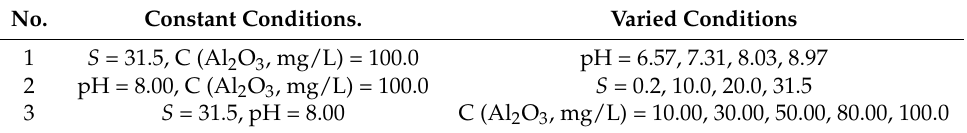
Table 2. Experiments on the sedimentation of nano-Al 2 O 3 ASW